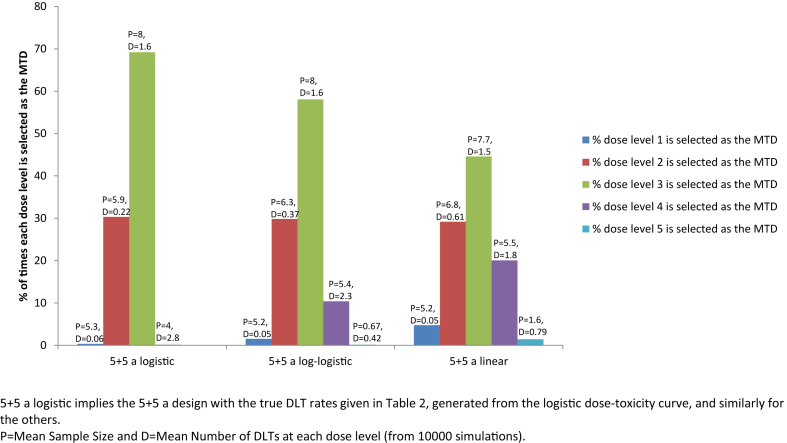
The figure depicts the percentage of times that the 5+5 a design selects each dose level as the MTD for the true DLT rates given in Table 2, generated from the three dose-toxicity curves. These percentages are from simulations and the results are shown in Table 3, Table 4, Table 5.